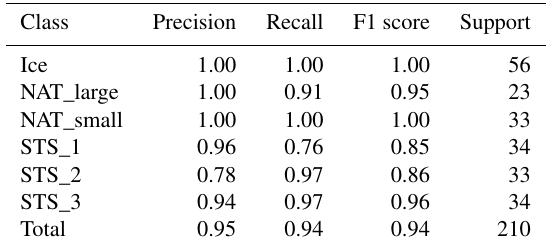
Table 6. Scores of the RF classifier on a small subset of CSDB